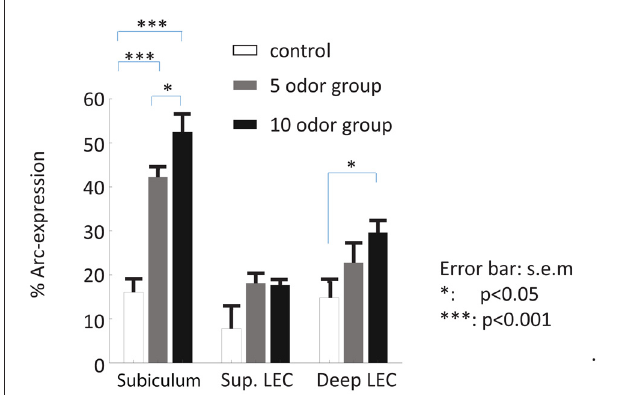
FIGURE 3 | Patterns of activity in the subiculum and LEC of delayed nonmatch to sample recognition memory task based on odors (DNMO) rats and home caged controls. A high proportion of subicular neurons expressed Arc during the retrieval of non-spatial memory while comparatively a smaller proportion did in the superficial and deep layers of the LEC. The proportions of Arc positive cells varied in function of the memory load only in the subiculum and the deep layers of the LEC. ∗ p < 0.05; ∗∗∗ p < 0.001; error bar: